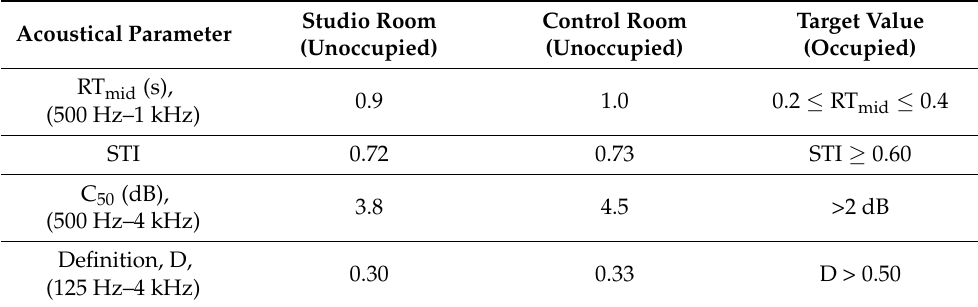
Figure 14. The initial reverberation time of the enclosures: ( a ) studio room; ( b ) control room. Table 9. Measured parameters of the enclosures under study.